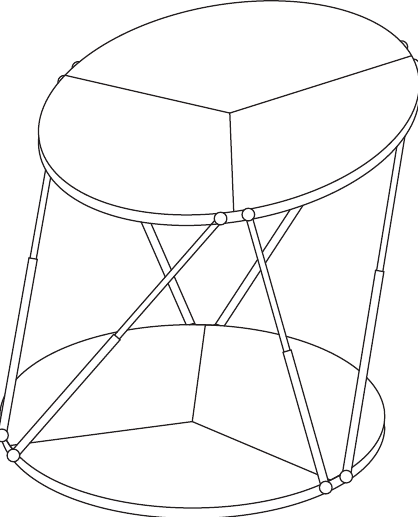
Figure 3: Schematic diagram of 6-DOF platform under pose